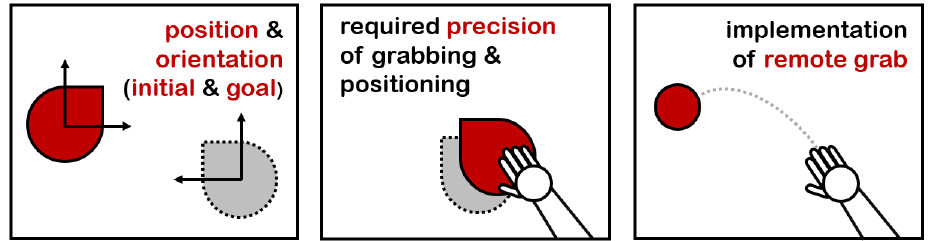
Figure 10. Examples of task-related parameters relevant for the implementation of pick-and-place